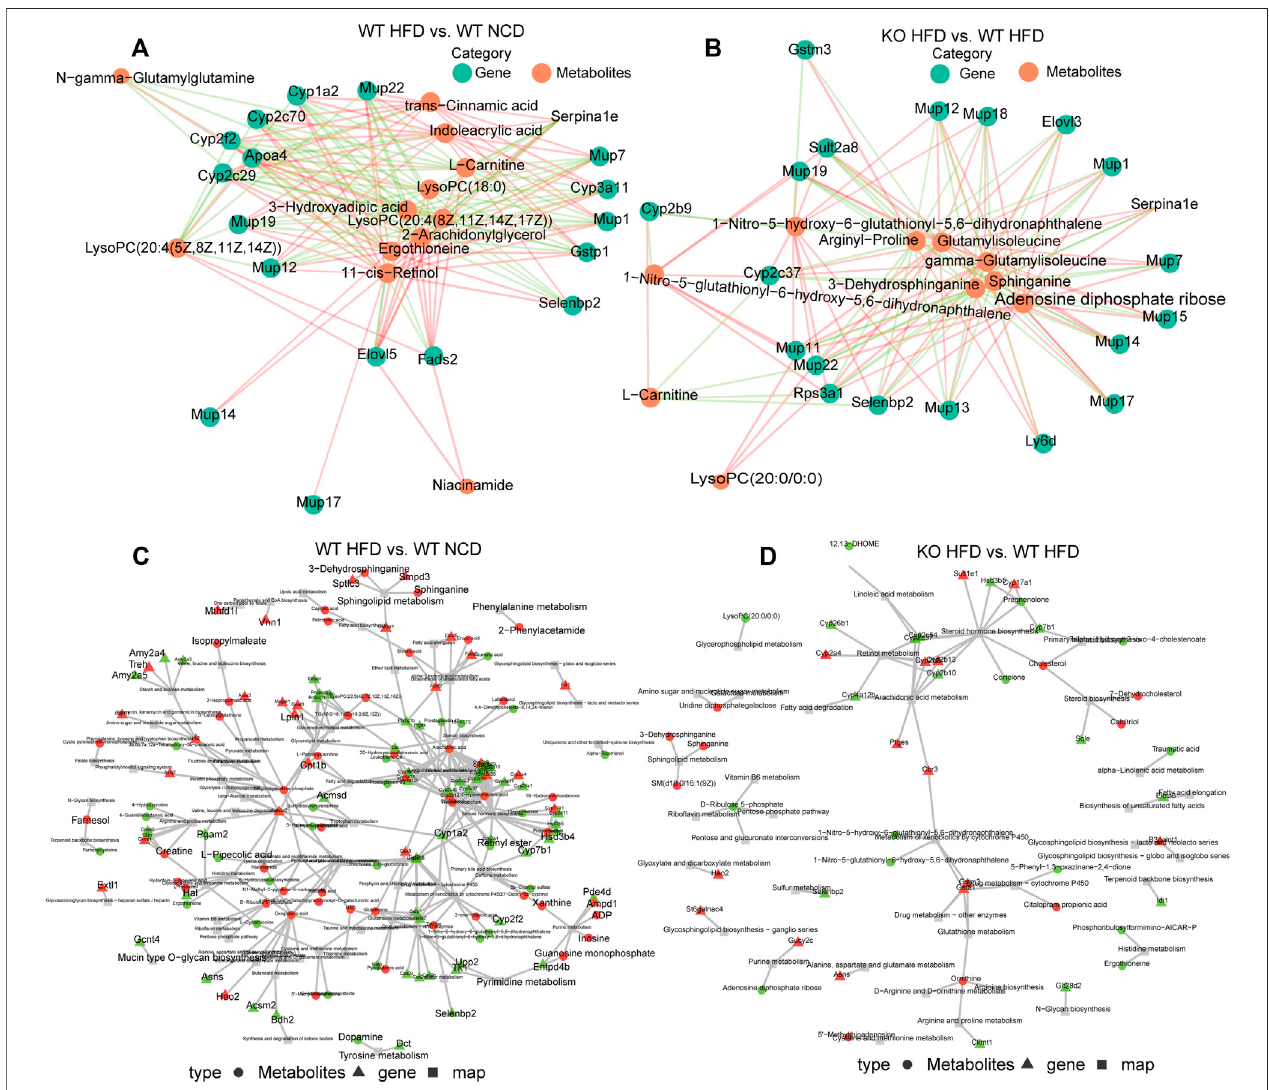
FIGURE 6 | Differently expressed genes and differential metabolites network. (A) Network diagram of expression correlation between differential genes and differentialmetabolitesbetweenWT-HFD andWT-NCDmice.The fi gureshowsthenetworkdiagrambasedonPearson ’ scorrelation analysistocalculatethecorrelation betweentheresponseintensitydataofgenesandmetabolites,andtherelationshippairswith p -value ≤ 0.05wereselected.Theredlinerepresentsapositivecorrelation, and the green line represents a negative correlation. The thickness of the line represents the correlation coef fi cient. (B) Network diagram of expression correlation betweendifferentialgenesanddifferentialmetabolitesbetweenCD1dKO-HFDandWT-HFDmice. (C) Differentiallyexpressedgenesandmetabolite-basedknowledge- guided machine learning (KGML) network diagram of WT-HFD and WT-NCD groups. Triangles represent genes, circles represent metabolites, and squares represent pathway names. Red is upregulated genes or metabolites, and green is downregulated genes or metabolites. (D) Differentially expressed genes and metabolites based on the KGML network diagram of the CD1d KO-HFD and WT-HFD groups. HFD, high-fat diet; KO, knockout; NCD, normal control diet; WT, wild-type.